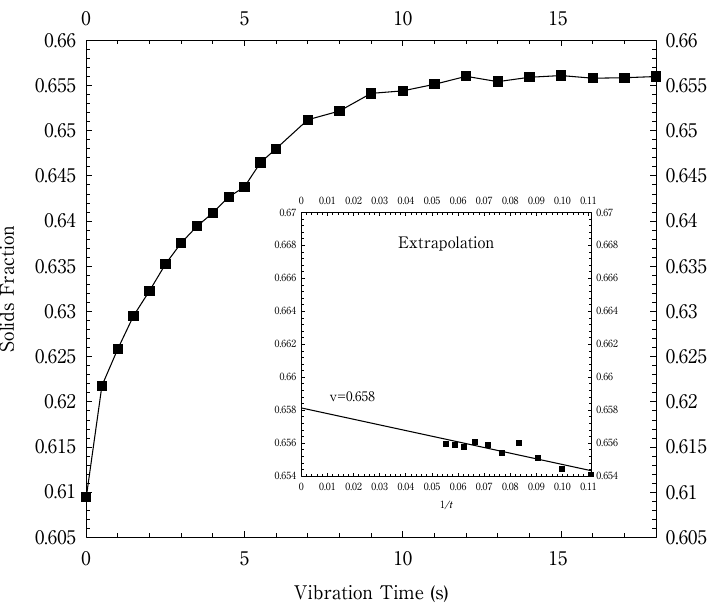
Fig. 10 Evolution of the solids fraction for an 8000 particle system ( L/d = 25) vibrated at a/d = 0.16 and f = 40 Hz. The extrapolated solids fraction (as 1/ t →∞ ) v ＝ 0.658 is shown in the inset.